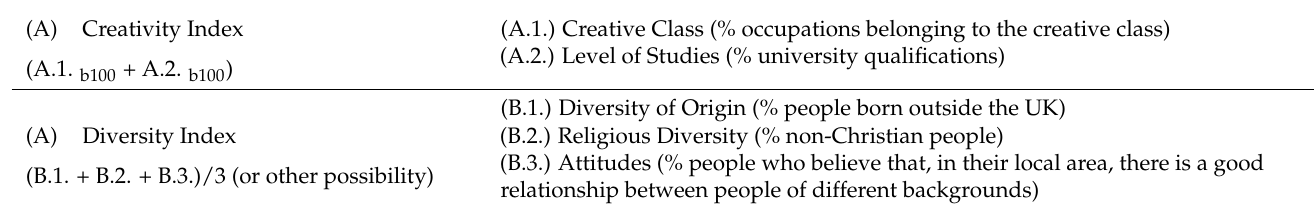
Table 1. Construction of the Creativity and Diversity